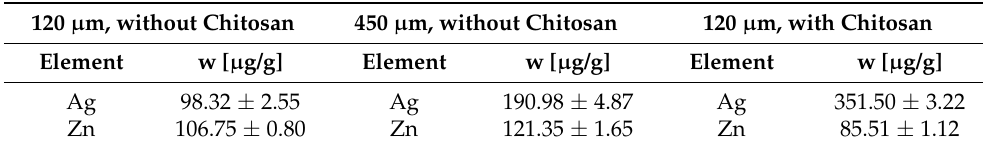
Table 1. Analysis of silver and zinc in microcapsules of different diameters (120 or 450 µ m) prepared with and without chitosan in their outer shell.